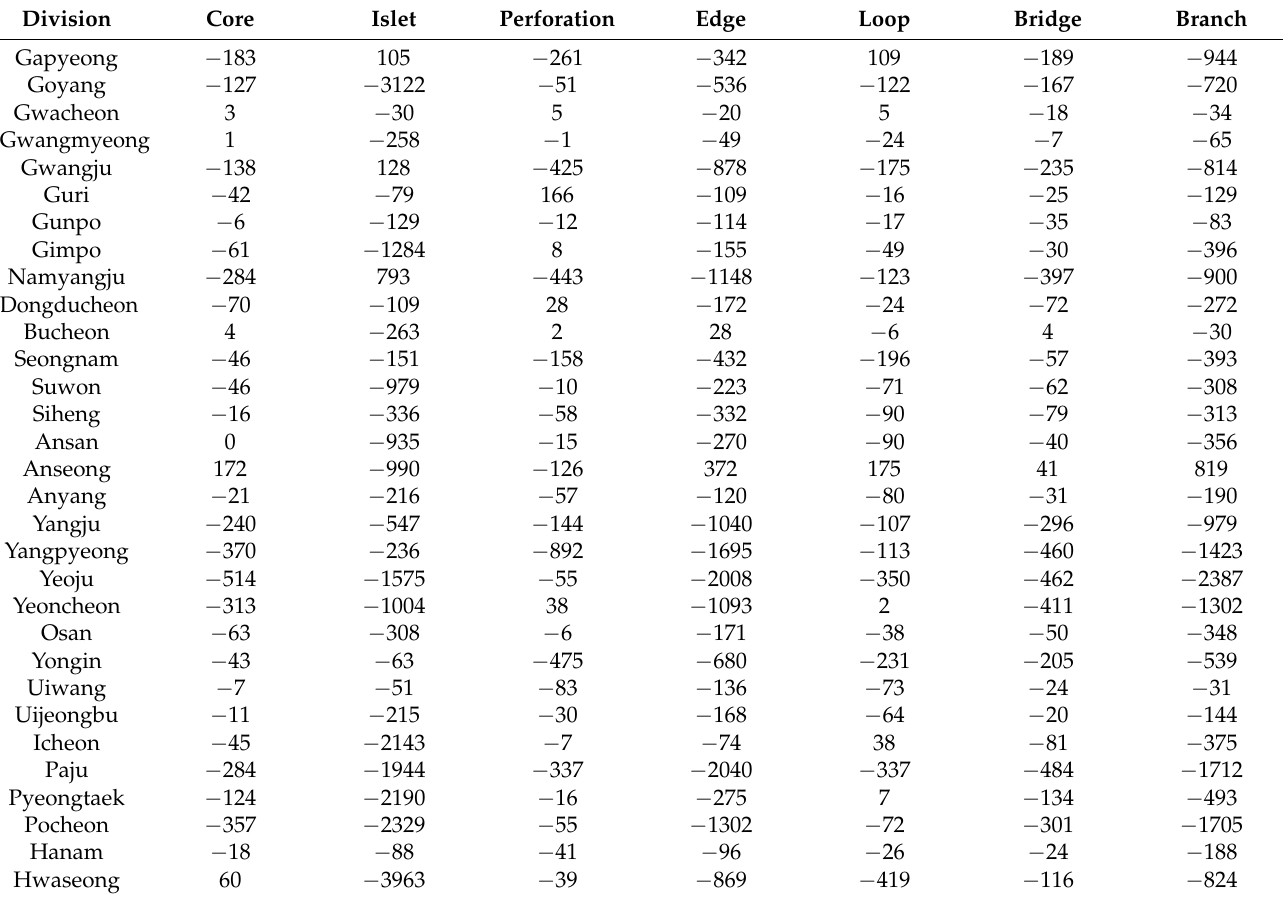
Table 3. Changes in MSPA categories by city